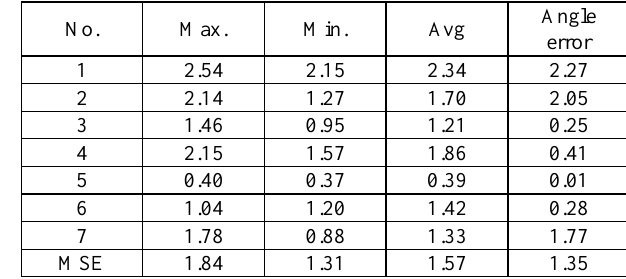
Table 1. The checking line residual in Vaihingen